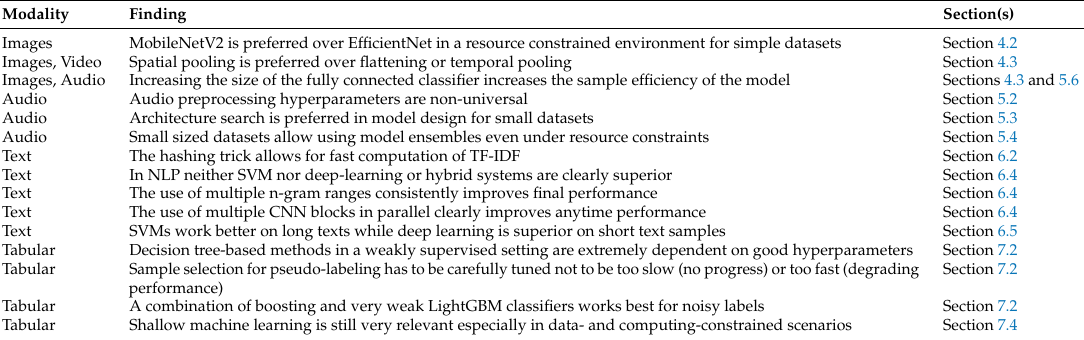
Table 13. Discussion: Overview of the identified patterns in the evaluations throughout this